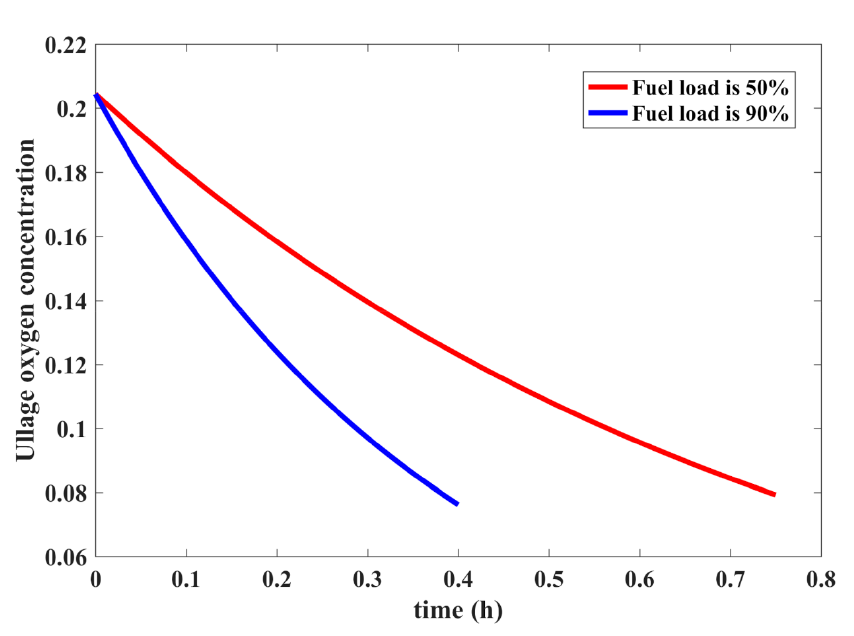
Figure 5. The ullage oxygen concentration z Uov regarding the fuel load, while keeping other pre- takeoff experimental variables